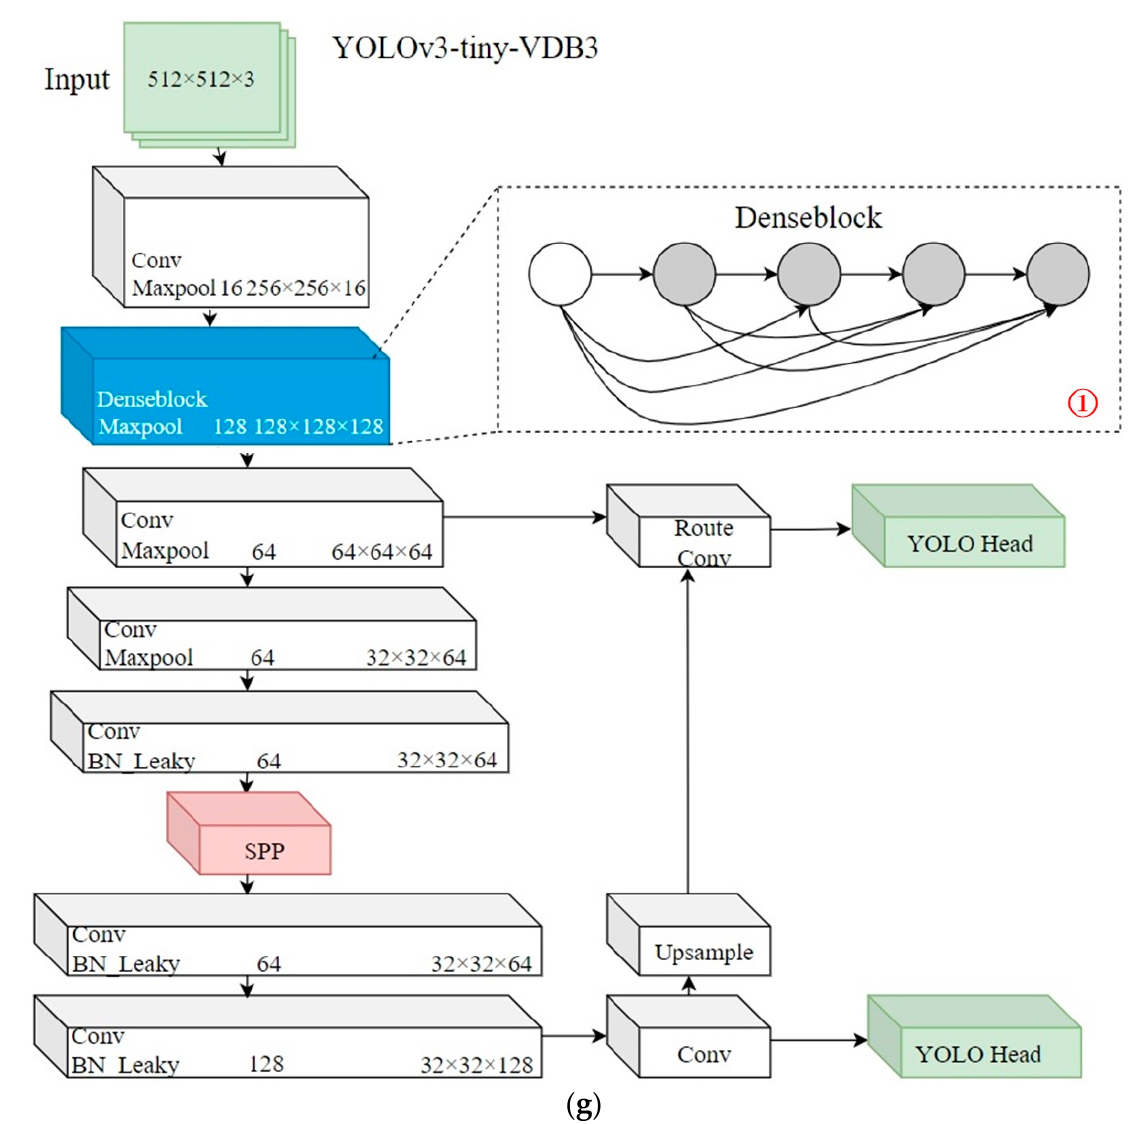
Figure 3. Structures of the basic and improved Yolov3-tiny networks [42–45]. ( a ) Structure of the classic Yolov3-tiny. ( b – d ) Structures of Yolov3-tiny-PDB1, Yolov3-tiny-PDB2, and Yolov3-tiny-PDB3: the network of ground pedestrian detection under excellent, ordinary, and severe imaging luminance conditions. ( e – g ) Structures of Yolov3-tiny-VDB1, Yolov3-tiny-VDB2, and Yolov3-tiny-VDB3: the networks of ground vehicle detection under excellent, ordinary, and severe imaging light conditions. The dashed boxes and their corresponding red numbers will be used in ablation analysis experiment.